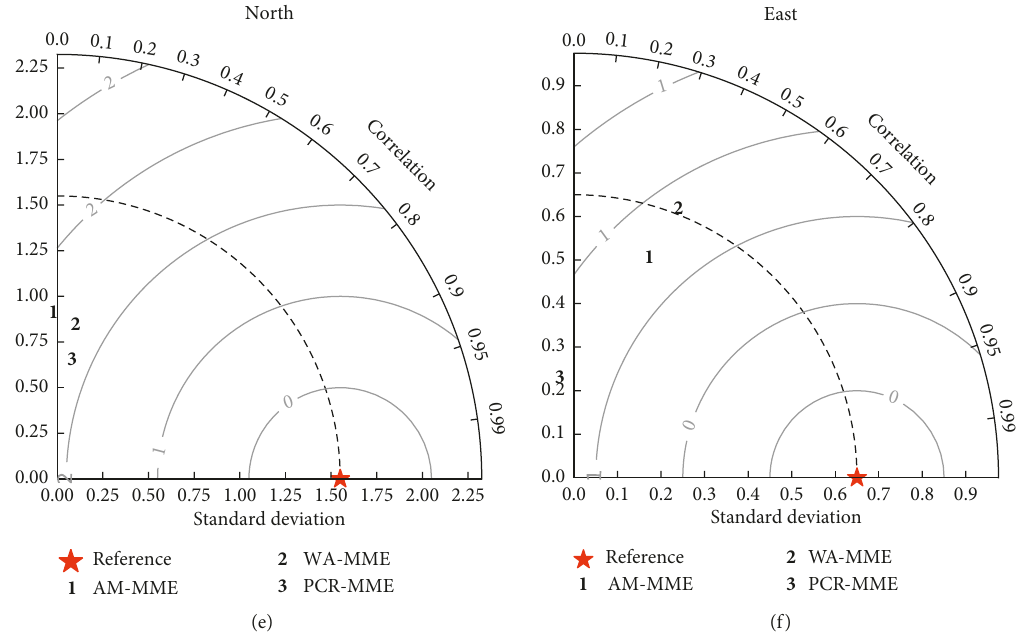
Figure 8: Correlation coefficient, root mean square error, and standard deviation for the JJAS period for all six climate zones: (a) delta zone; (b) southern zone; (c) coastal zone; (d) dry zone; (e) northern zone; (f) eastern shan zone in Myanmar. Reference point denotes the standard deviation for observation for each zone,